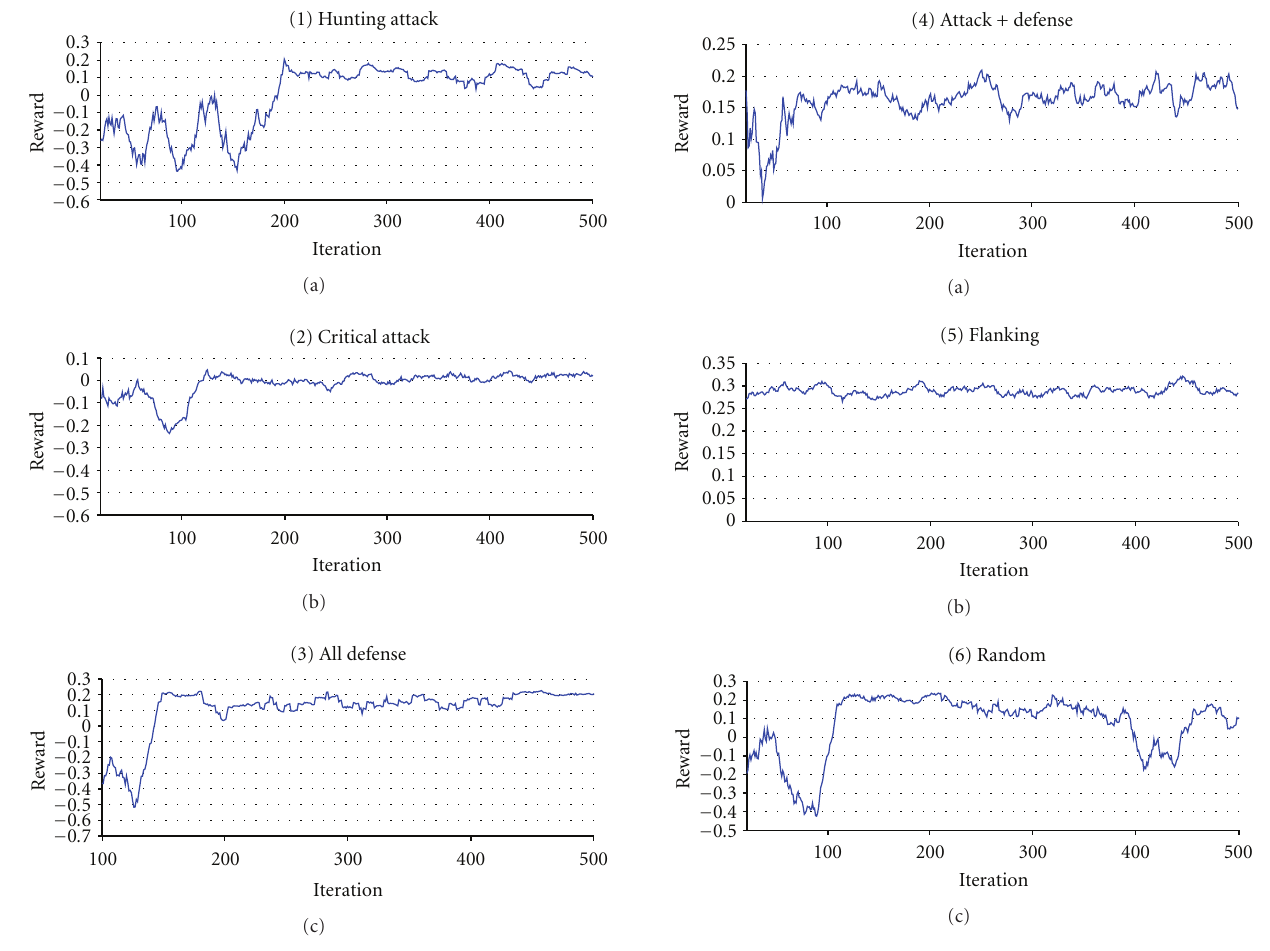
Figure 12: Generality test results for the SAP hierarchical learning framework: experiment sets 1, 2, and 3. The first three of six sets of experimental setups where each setup consists of Team B having a di ff erent fixed strategy. Each experiment set has the reward value plotted against the number of iterations. Note that in order to maximize visibility, the scales are not uniform across all graphs.